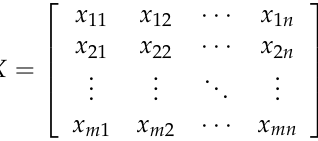
1. Combining criteria evaluation data into matrix X where one dimension represents the index of a chromosome, and another dimension represents the index of the criteria (6);